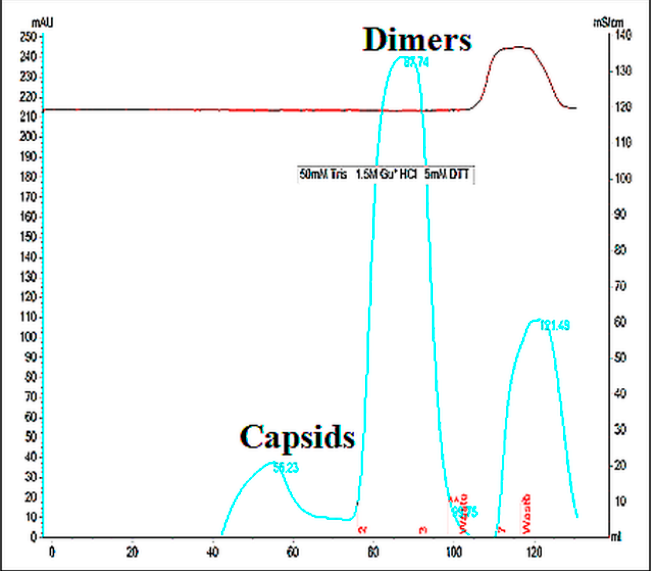
Figure 4 . Analysis by Superdex200 gel filtration of HBc/G VLPs after the incubation of VLPs in dissociation buffer containing GuHCl/LiCl and removal of insoluble material.